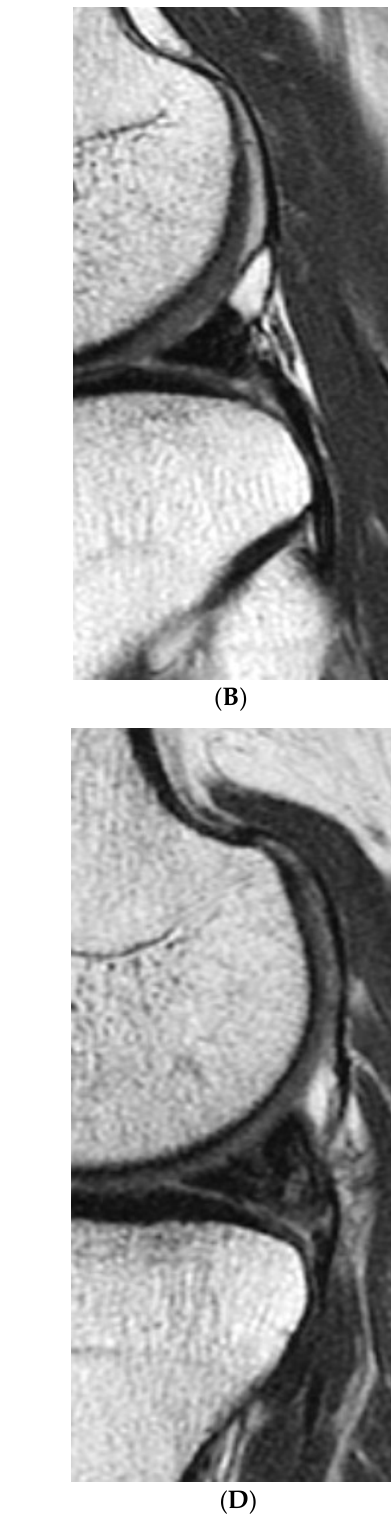
Figure 8. Graft signal. ( A ) Grade 0, ( B ) Grade 1, ( C ) Grade 2, and ( D ) Grade 3. The cartilage status at the lateral compartment was assessed according to the MOG (grade 0, normal; grade 1, cartilage surface fibrillation; grade 2, <50% loss of cartilage thickness; grade 3, ≥50% loss of cartilage thickness; grade 4, exposed subchondral bone) [32–34]. The worst MOG of the lateral femoral condyle (LFC) and lateral tibial plateau (LTP) was used to present the overall status of the lateral compartment [35]. The cartilage status was categorized into three groups: low-grade (MOG ≤ 2) cartilage lesions on LFC or/and LTP; high-grade (MOG ≥ 3) cartilage lesions on either LFC or LTP; and high-grade cartilage lesions on both LFC and LTP [31]. Radiological measurements were independently performed by one experienced or- thopedic surgeon and one experienced radiologist (D.W. Lee and S.G. Moon). Each exam- iner measured twice with a 6-week interval, and the mean value was used. In the grading system, if there were different results between the two examiners, the results were deter- mined based on consensus. 2.4. Clinical Evaluation The clinical outcomes were evaluated using the Lysholm score and International Knee Documentation Committee (IKDC) subjective knee score. Preoperative data and postoperative data at 12 months were compared. 2.5. Statistical Analysis Statistical analysis was performed using the SPSS software (IBM SPSS Statistics 21; IBM Corp, Somers, NY, USA). In all analyses, statistical significance was set at p < 0.05. The independent t-test or Mann–Whitney U test was used to compare parametric varia- bles between the two groups. Preoperative and postoperative parametric or non-paramet- ric variables were compared using the paired t-test or Wilcoxon signed-rank test in each group. The intraobserver and interobserver reliabilities of measurements were presented with the intraclass correlation coefficient (ICC) [36]. To detect a difference of 2 mm in graft